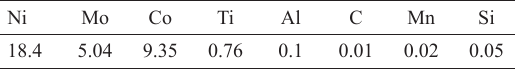
Table 1: Chemical composition of Maraging 300 steel (wt %).